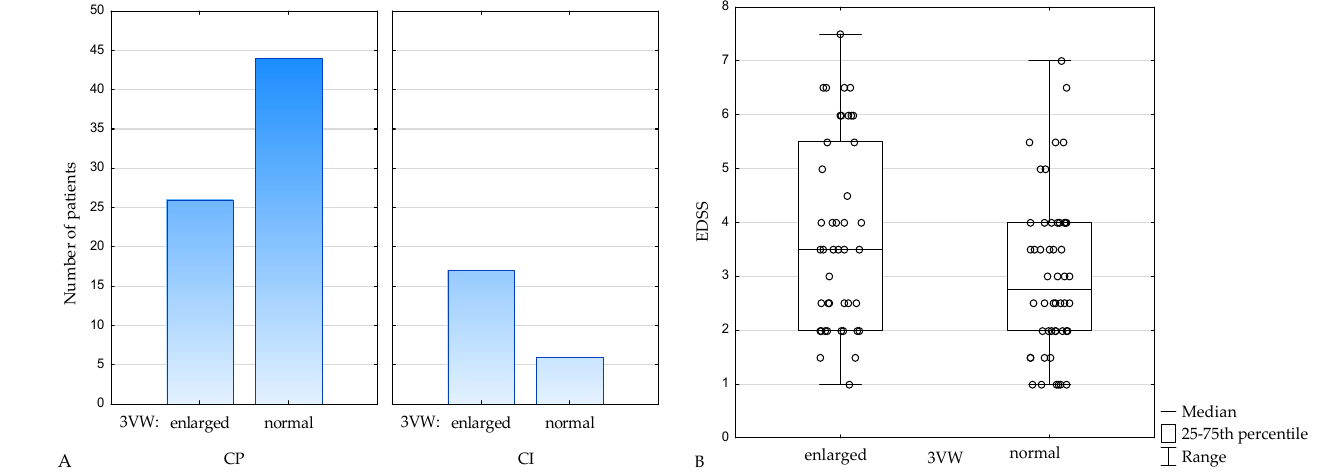
Figure 2. Number of patients with enlarged and normal 3VW in cognitively preserved (CP) and cognitively impaired (CI) subgroups ( A ), EDSS in patients with enlarged and normal 3VW ( B ). 3VW—the third ventricle width, CP—cognitively preserved, CI—cognitively impaired, EDSS— Expanded Disability Status Scale.